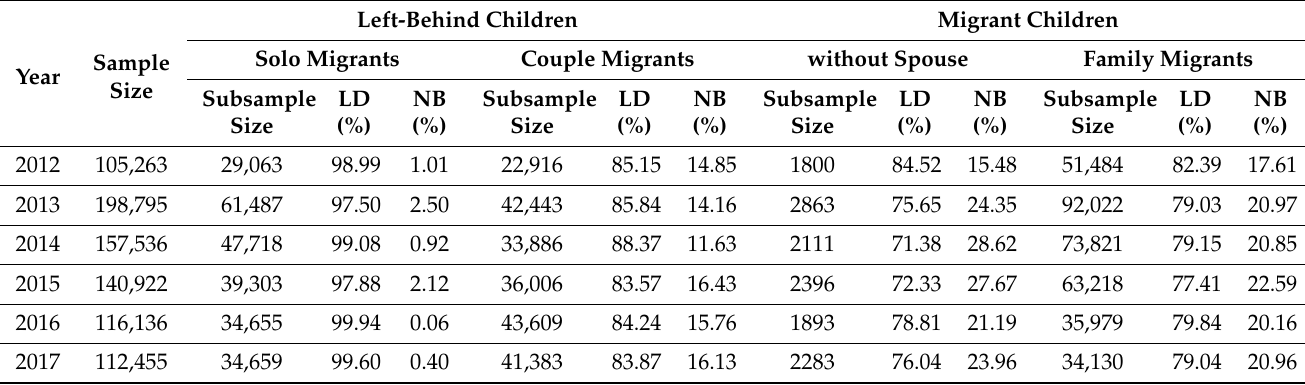
Table 1. Trends in family migration patterns,